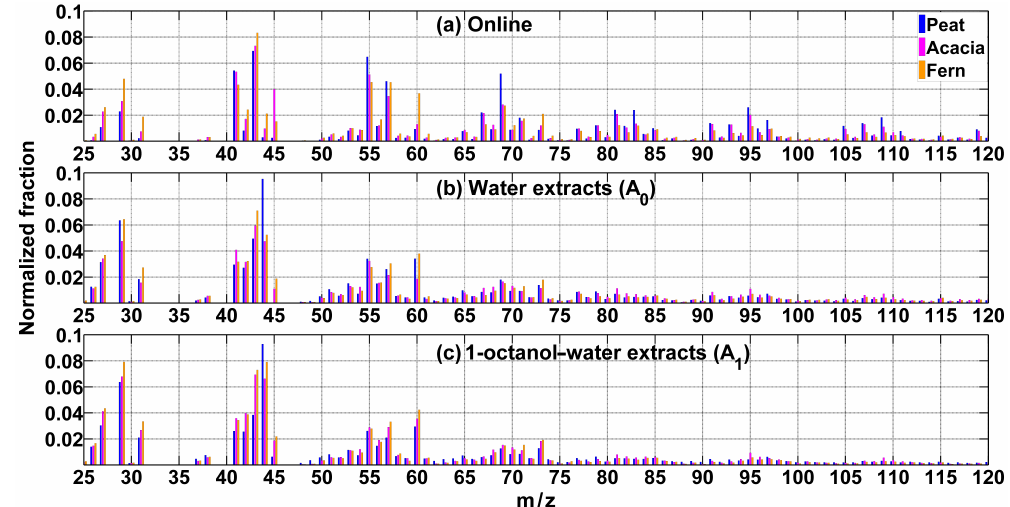
Figure 6. Mass spectra of organics in Indonesian biomass burning particles measured for peat, acacia, and fern samples. (a) Online, (b) A 0 , and (c) A 1 data are shown. Ion signals ( m/z ) from hydrocarbon-like organic compounds (e.g., m/z 41, 43, 55, 57) are prominent for online data, while intensities of ions for oxygenated organics (e.g., m/z 44) and biomass burning tracers (e.g., m/z 60, 73) are relatively less intense. On the other hand, both m/z 44 and m/z 60 signals are significant for mass spectra of A 0 and A 1 . See the text for details.